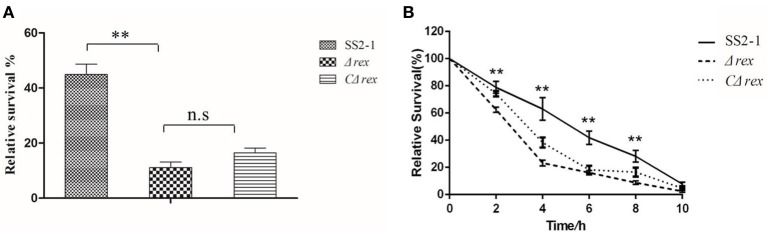
(A) Survival of WT SS2-1 in pig whole blood compared to that of the mutant strain Δrex and complemented strain CΔrex. Mixtures were incubated at 37°C for 2 h. A value of 100% was given to the CFU at time 0 h. The survival rate of Δrex was significantly reduced compared to SS2-1. (B) Intracellular growth of SS2 in RAW264.7 macrophages. The macrophages cells were infected with mid-log growth phase SS2 strains at a MOI of 10 (bacteria: macrophage).The samples were taken 1 h after the addition of antibiotics (time zero) and then at 2, 4, 6, 8, and 10 h. The relative numbers of CFU (rCFU) were estimated by plating out the lysates of infected macrophages and counting the numbers of CFU at each time point. Asterisks indicate the time points when the intracellular bacteria survival rates elicited by the Δrex were significantly lower than those produced by WT infection.